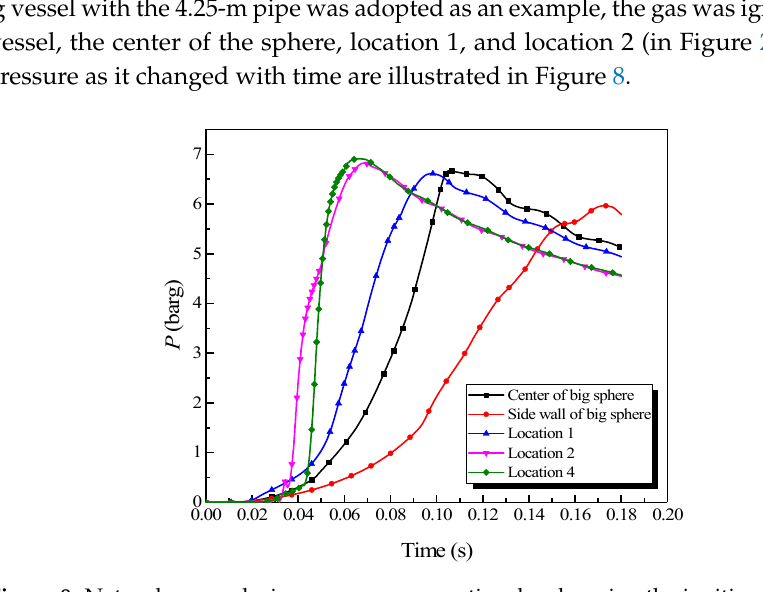
Figure 7. Profiles of the natural gas explosion parameters (temperature and concentration of products) in the single vessel with a pipe connected to it.